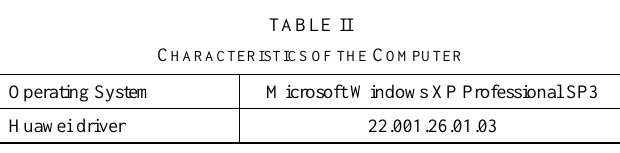
LMT cellular network operators respectively.